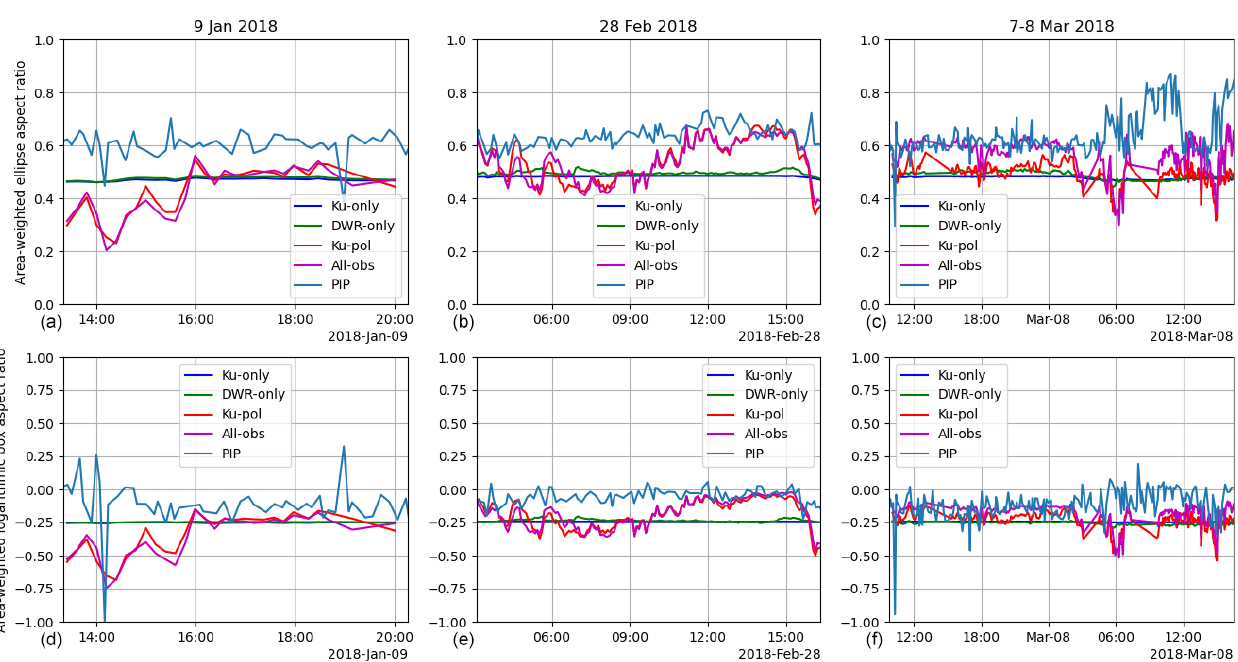
Figure 13. Time series of D3R- and PIP-derived area-weighted ellipse (a, b, c) and box (d, e, f) aspect ratio for each